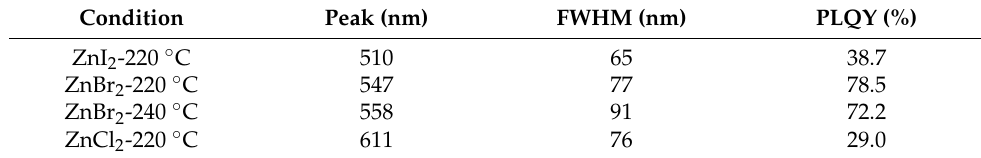
Figure 2. PL spectra of InP/ZnS/ZnS QDs synthesized using different synthetic conditions, the inset shows a photo of these QD solutions under excitation of 365 nm UV light. Table 1. Emission properties of the InP/ZnS/ZnS QDs synthesized at different conditions.